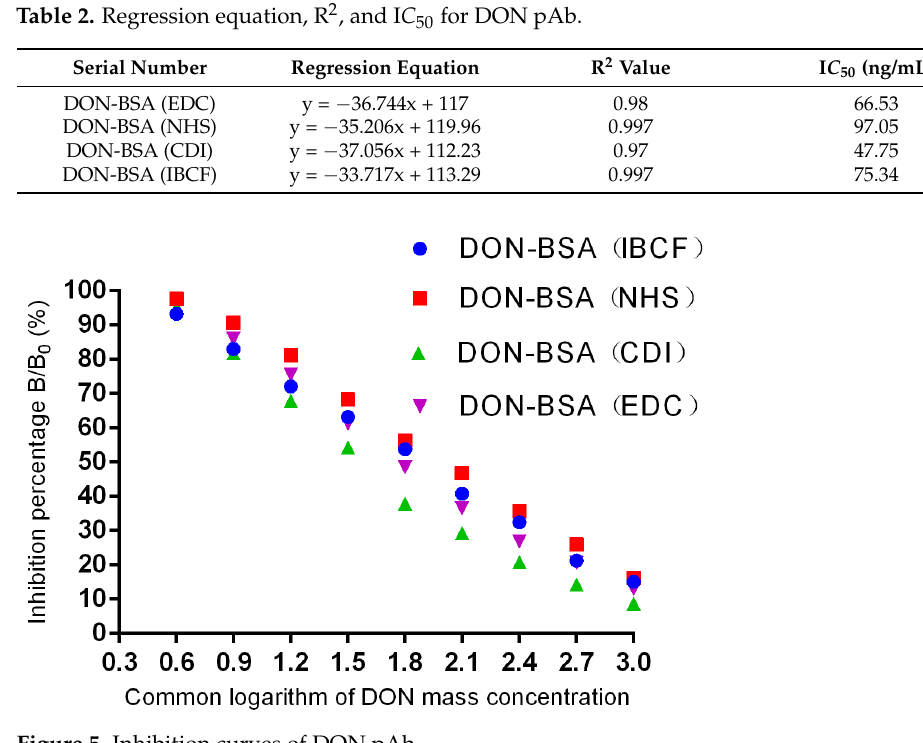
Figure 4. The titre curves of DON pAb identification.